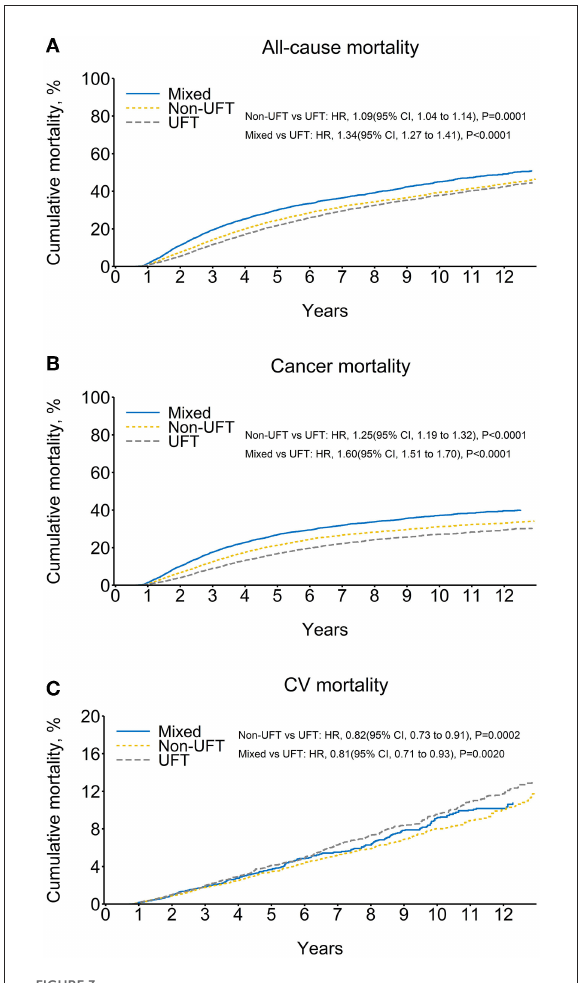
FIGURE3 Cumulative mortality among patients with stage II–III colorectal cancer, after SIPTW (SIPTW, stabilized inverse probability of treatment weighting using propensity score; UFT,